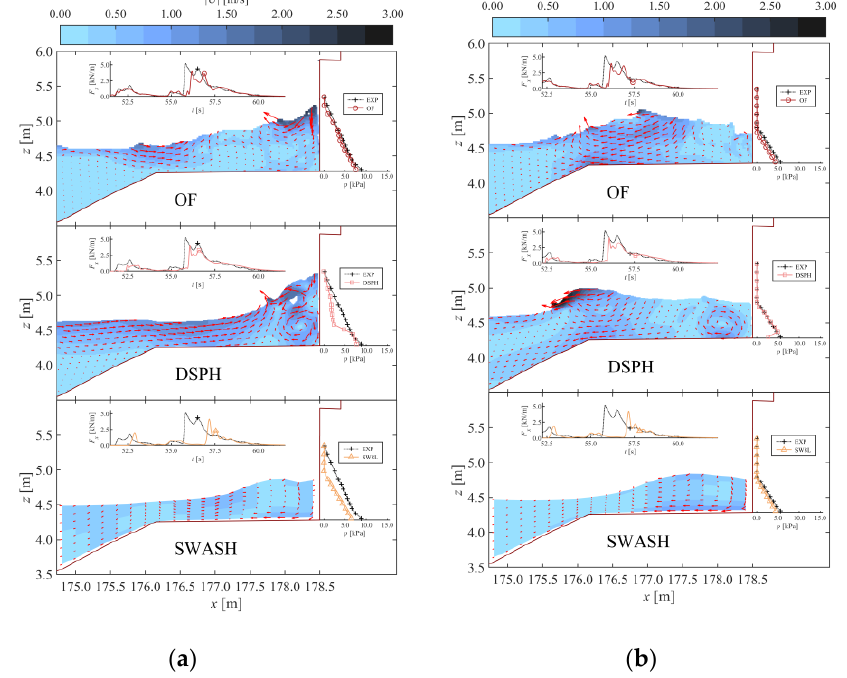
Figure 16. Figure 15 continued: ( a ) time instant 6; ( b ) time instant 8.